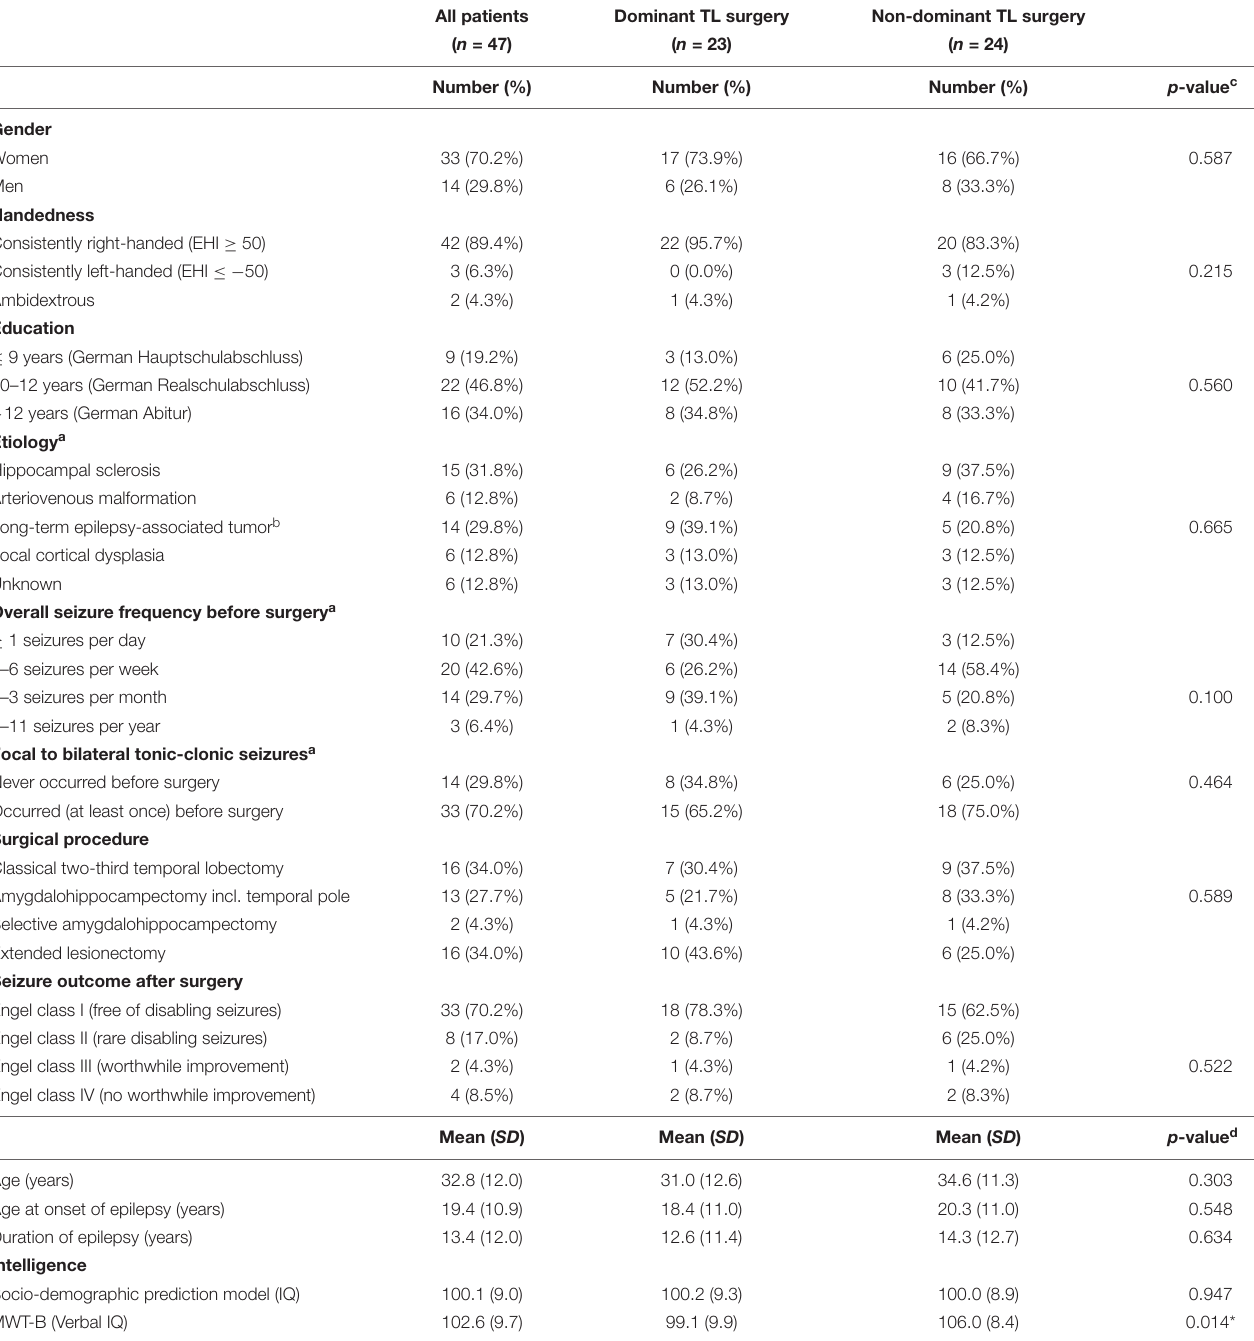
TABLE 1 | Socio-demographic and clinical characteristics of the full sample ( n = 47) and the two subgroups of patients with dominant TL surgery ( n = 23) and patients with non-dominant TL surgery ( n = 24). All patients Dominant TL